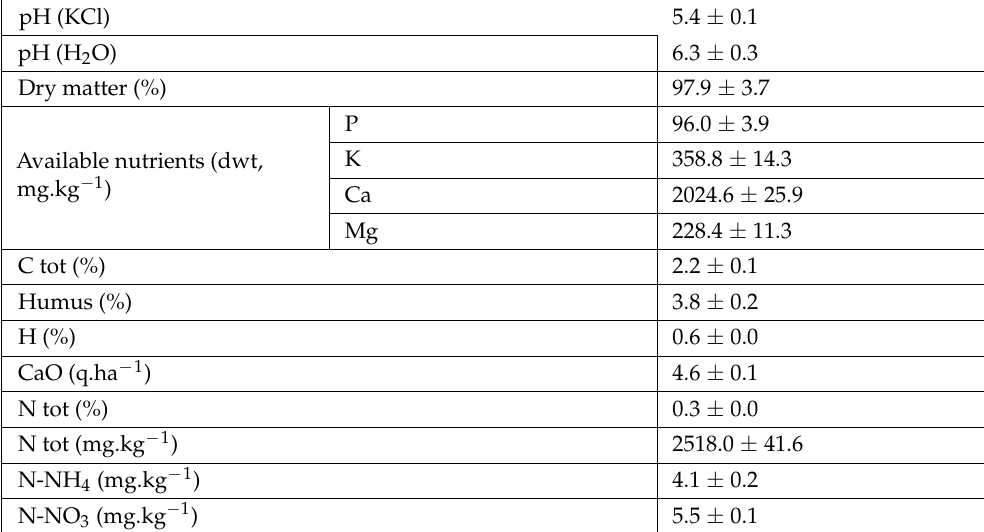
Table 1. Soil parameters in the experimental field at the Crop Research Institute in Chomutov, North Western Czechia. Results are expressed as means ± SD ( n = 4)